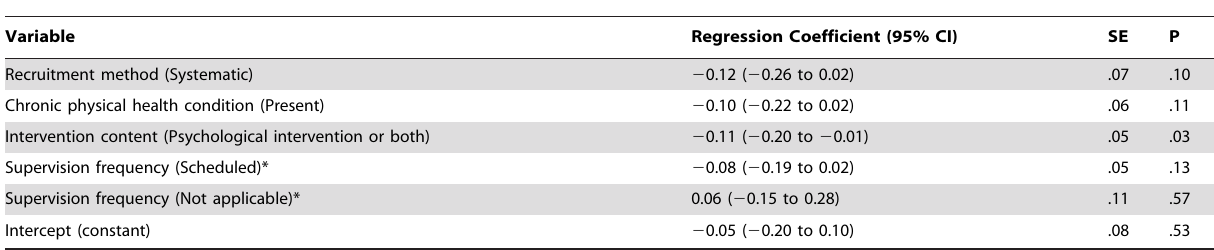
Table 5. Multivariable predictors of depressive symptoms (N =84).